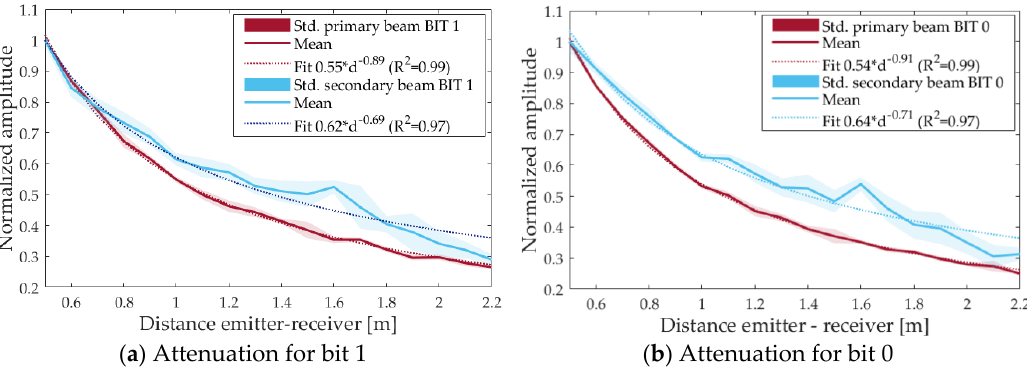
Figure 6. Normalized amplitude of the received signal for primary (red) and secondary (blue) beam as a function of distance between emitter and receiver. Std means the standard deviation. ( a ) for bit 1; ( b ) for bit 0.